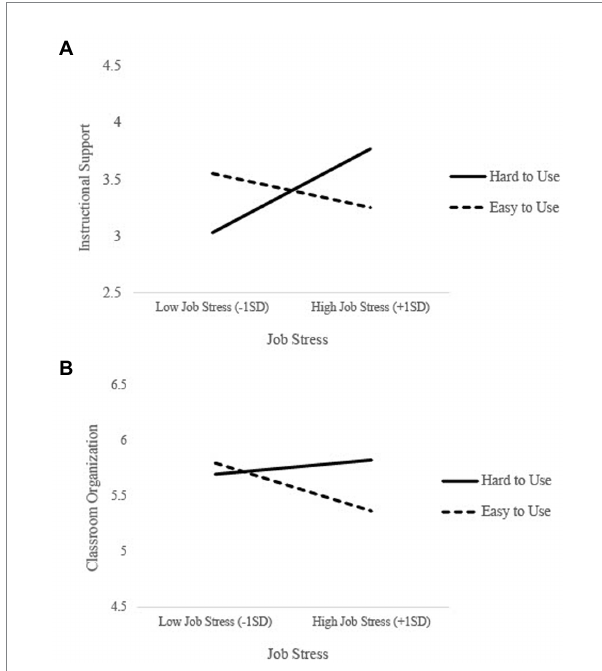
FIGURE 1 The effect of job stress on implementation quality was moderated by teachers’ perception of feasibility of PAX GBG + MTP. Teachers experiencing high levels of stress and felt the program was harder to use demonstrated greater (A) instructional support, and (B) classroom organization than those who were highly stressed and reported the program was easy to